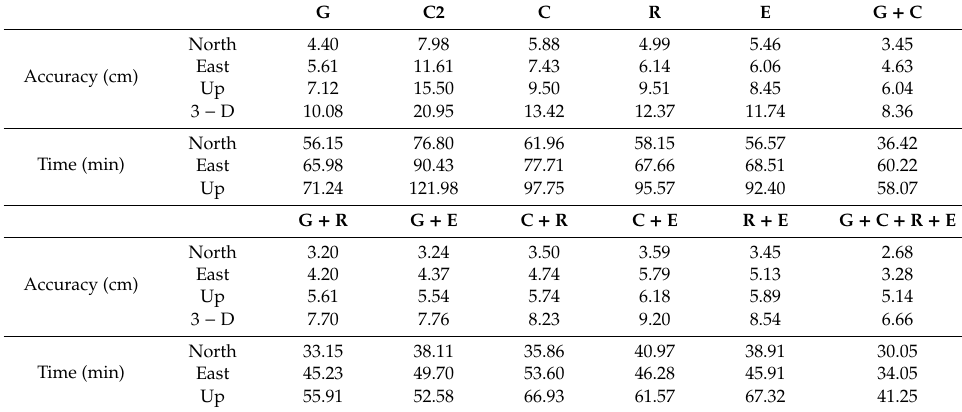
Table 3. Kinematic PPP accuracy and convergence